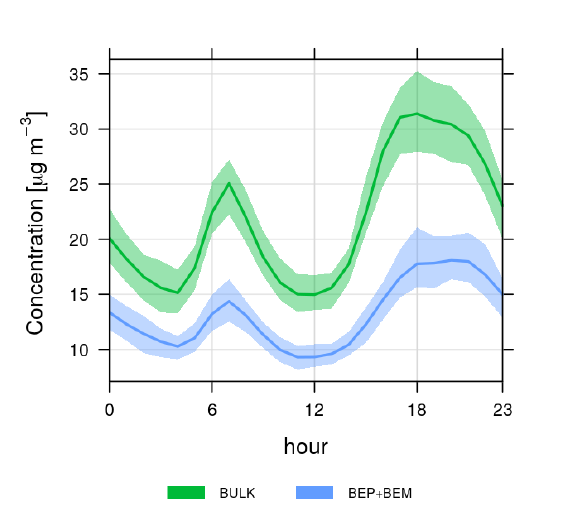
Figure 9. Averaged diurnal profiles of PM primary aerosol for BULK simulations (green) and BEP+BEM simulations (blue). Lines represent the mean values and shaded areas the 95% confidence interval in the mean.